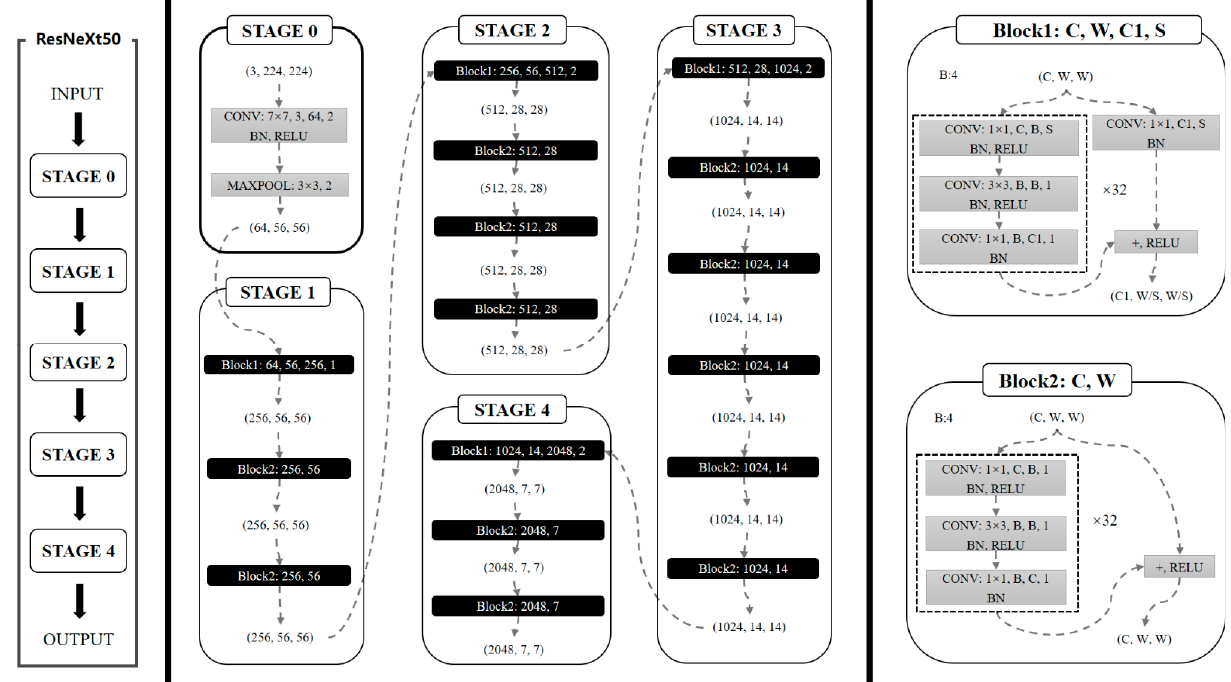
Figure 3. Model structure.